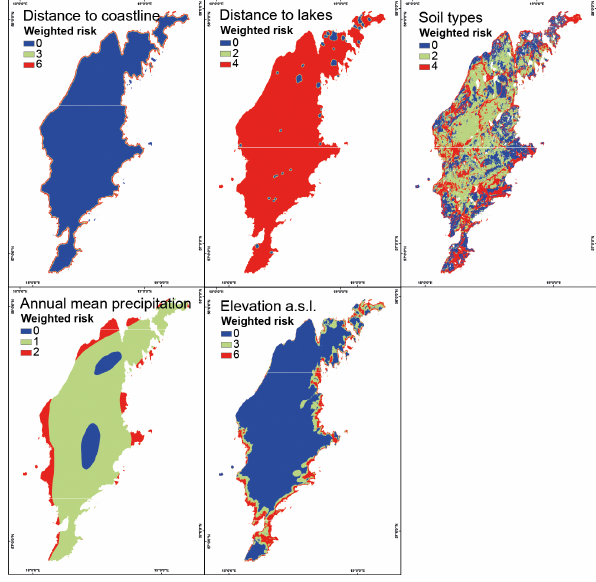
Figure 5. Factors included in the risk analysis for saltwater intru- sion (see Table 2 for values and Fig. 6 for visual